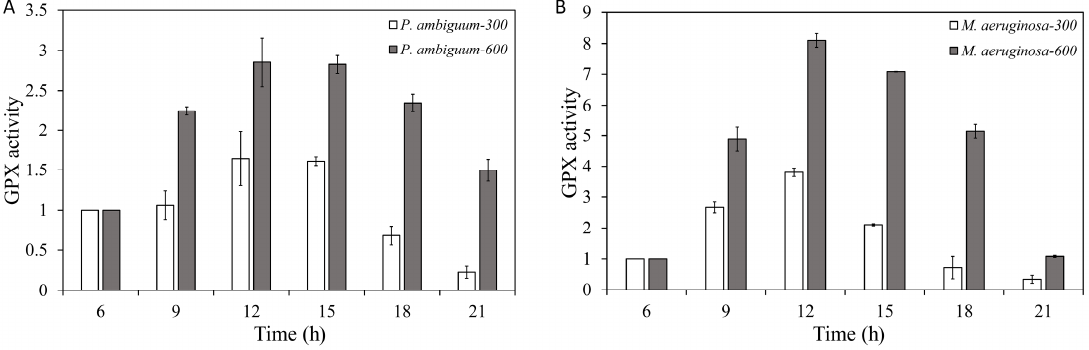
Figure 2. Diurnal variations in the guaiacol peroxidase (GPX) activities of P. ambiguum (strain NIES 2119) ( A ) and M. aeruginosa (strain NIES 111) ( B ). The numbers 300 and 600 represent the maximum PAR intensities (in µmol·m −2 ·s −1 ) for two different treatment conditions, where the maximum PAR intensity was reached at 12:00 h. The error bars represent the standard deviations.